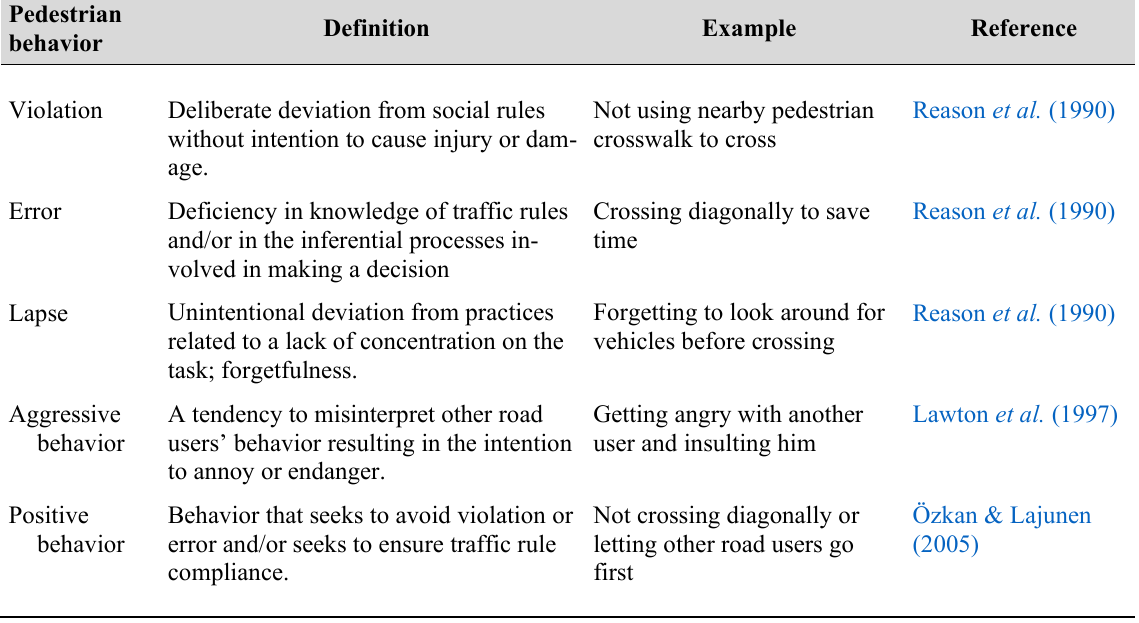
Table 1 Definitions of different types of pedestrian behaviors (Deb et al.